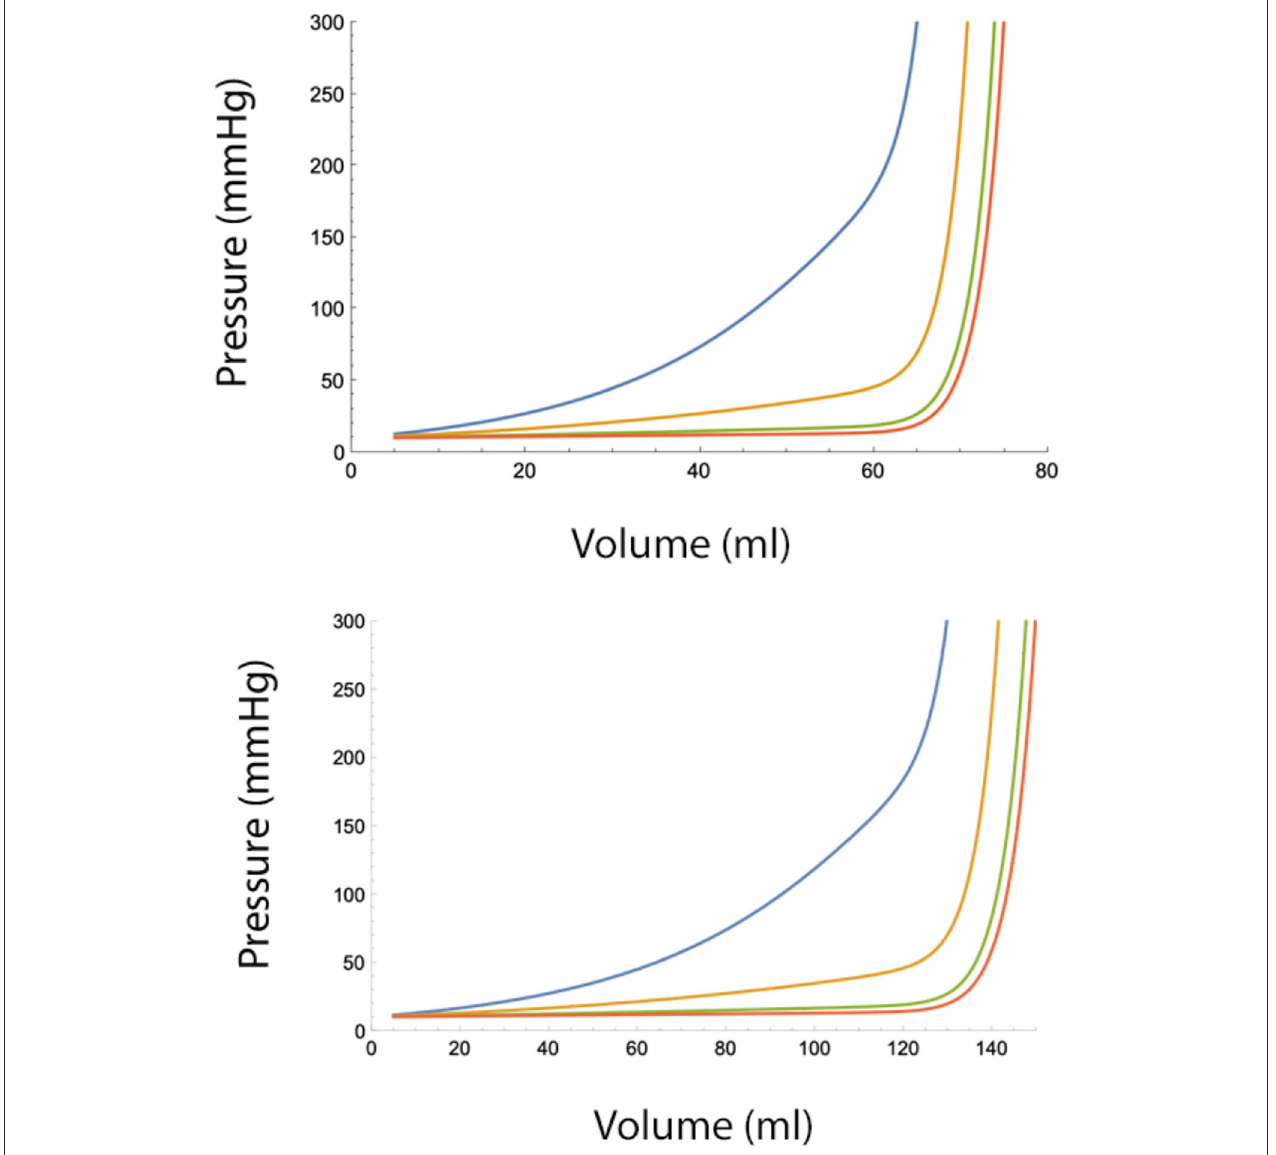
FIGURE 4 | (Top) Epidural pressure after epidural fluid injection over 30min under moderately severe adverse conditions (A is divided in n smaller aliquots, where n injection over 30min under normal conditions (A (green), and n 20 (red). Pbaseline =